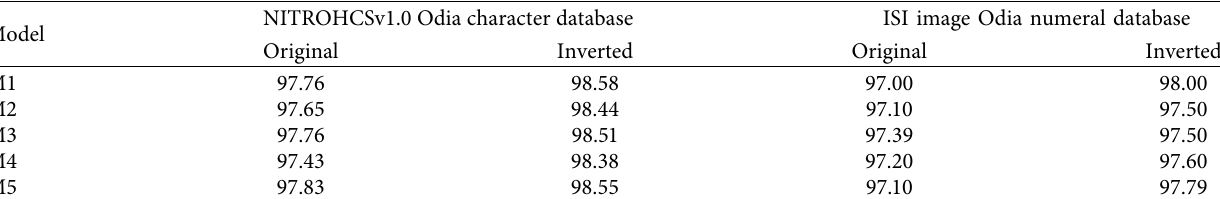
Figure 8: Example of color inversion. Table 8: Efect of color inversion on